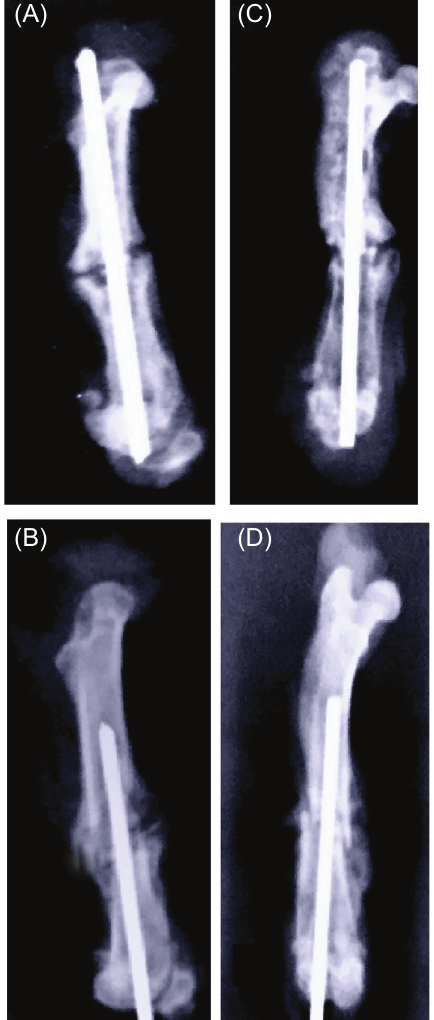
Figure 1. Radiographic progression of fracture healing. A : Radio- graphic image of a fractured femur from Group A on the 15th day. B : Radiographic image of a fractured femur from Group B on the 30th day. C : Radiographic image of a fractured femur from Group C on the 15th day. D : Radiographic image of a fractured femur from Group D on the 30th day.